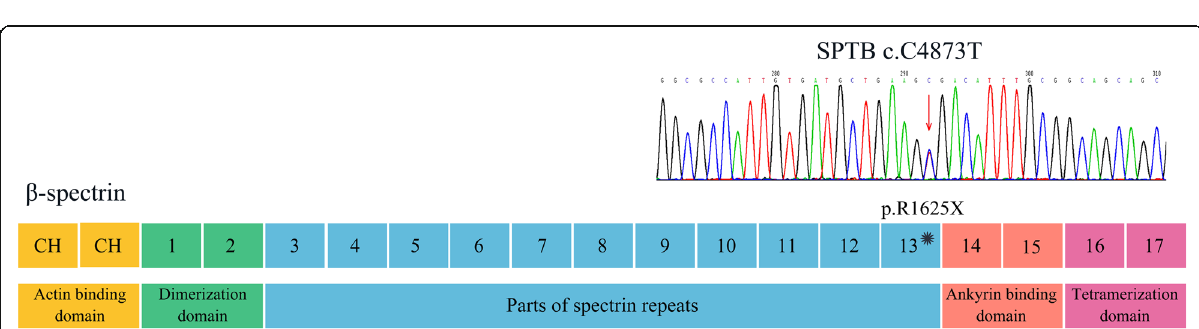
Fig. 2 Sanger sequencing of the pathogenic SPTB c.C4873T mutation in proband D and the localization of the mutation in schematic diagram of β -spectrin. A heterozygous c.C4873T (p.R1625X) mutation in SPTB gene, which encodes β -spectrin, was identified in proband D. Human erythroid β -spectrin molecule consists of two N-terminal calponin homology (CH) domains responsible for actin binding and seventeen β -spectrin repeats including dimerization domain (repeats 1 and 2), Ankyrin binding domain (repeats 14 and 15) and a tetramerization domain (repeats 16 and 17). The nonsense R1625X mutation was located on β -spectrin repeat 13. The red arrow indicates C4873T mutation detected in Sanger sequencing. The asterisk indicates the position of R1625X mutation in β -spectrin. SPTB , spectrin